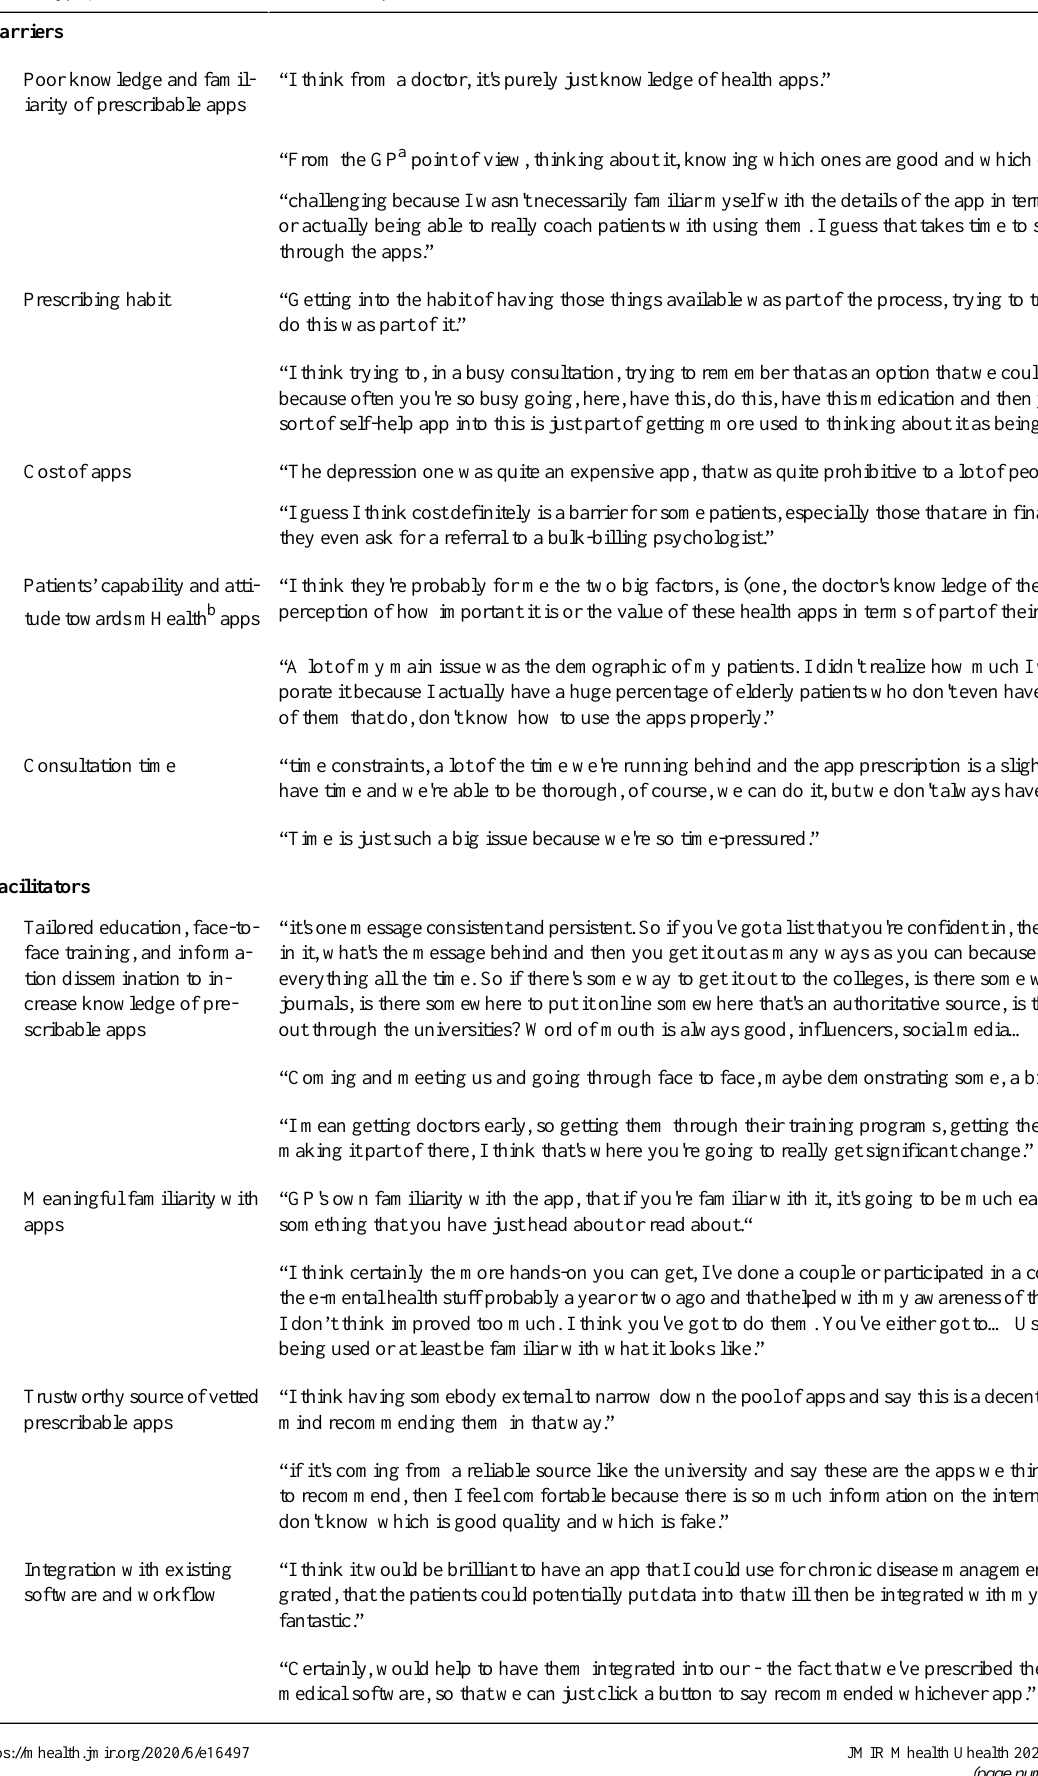
Table 2. Key themes and illustrative quotes around barriers and facilitators of mobile health app prescription in general practice. Illustrative quotesTheme type,